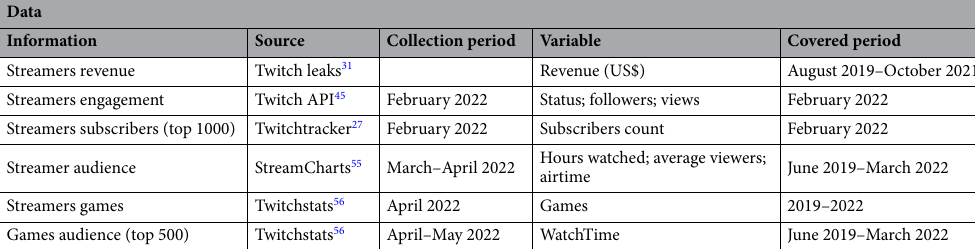
Table 1. List of data sources. All data sources, with the exception of the Twitch leaks, come, indirectly, from the Twitch API. The other websites mentioned only function as data aggregator (since the Twitch API only returns live information) allowing to create time series for the different metrics. Whereas every aggregator has a different way to collect data, they nonetheless typically make a collection every 15 min and then aggregate the different metrics on an hourly or daily